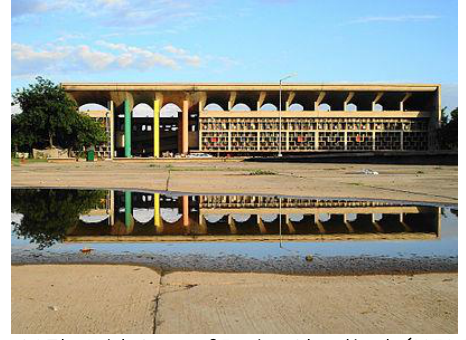
Fig. 24 The High Court of Justice, Chandigarh (1951-56)